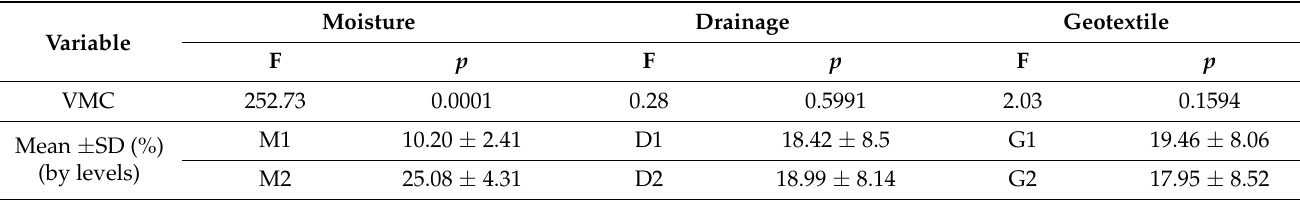
Table 7. Statistics for the VMC (f and p -value), mean and standard deviation of VMC for the three factors moisture, the presence of a drainage package and the addition of